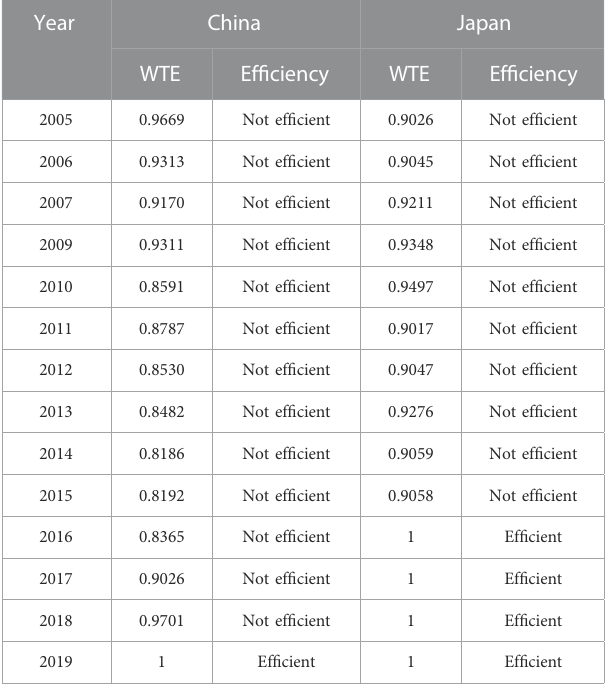
TABLE 1 DEA model results for China and